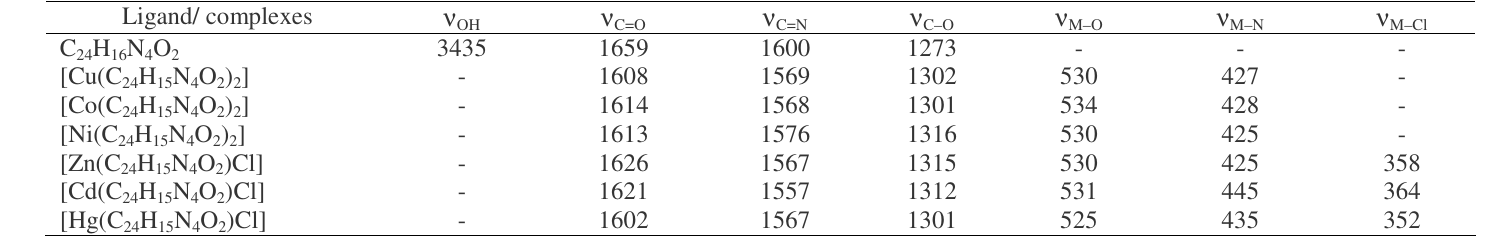
Table 3 . Important spectral IR bands of the ligand [HQMAPQ] and its metal (II) complexes Ligand/ complexes